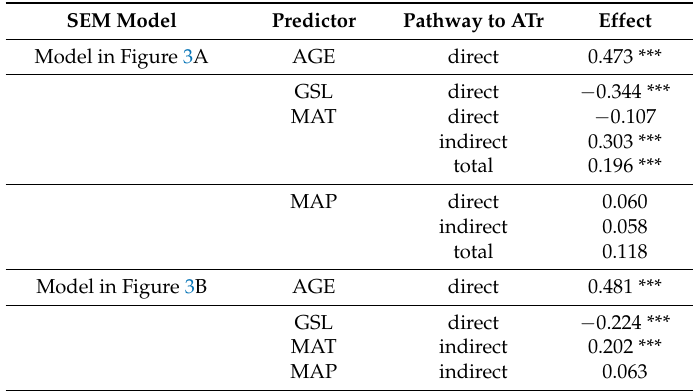
Table 4. Direct, indirect, and total standardized effects on ATr based on structural equation